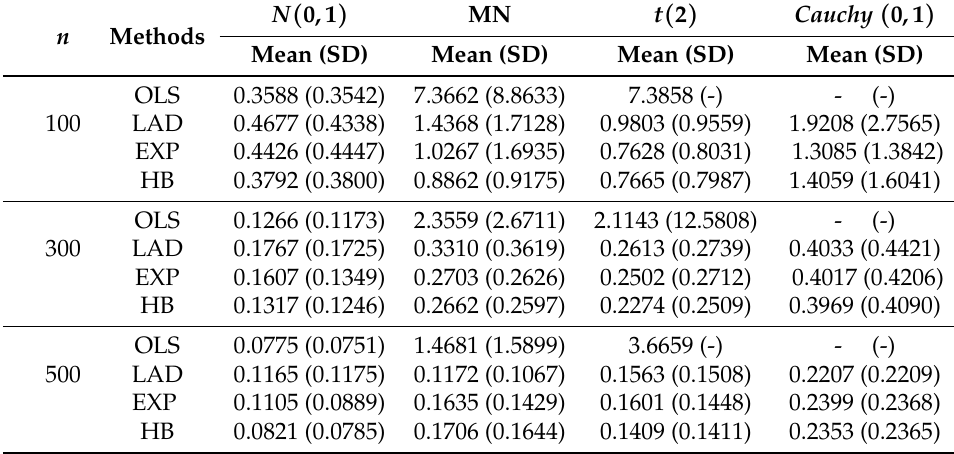
Table 4. The mean (SD) of MSPE under different error distributions and sample